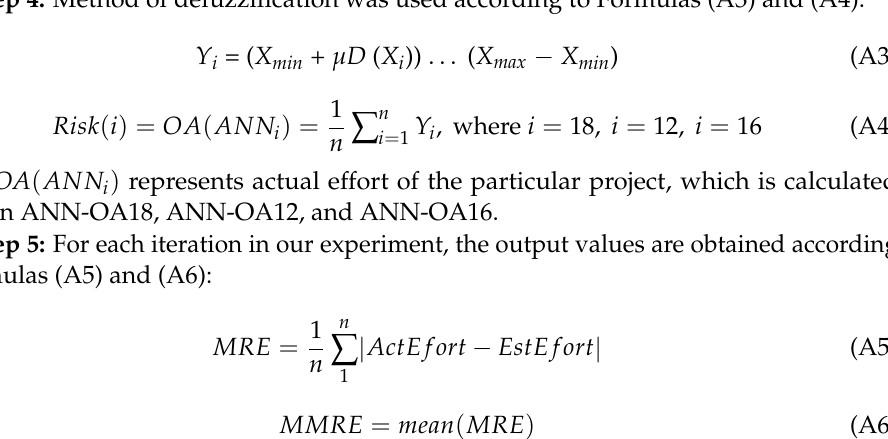
Algorithm—Taguchi robust design of the